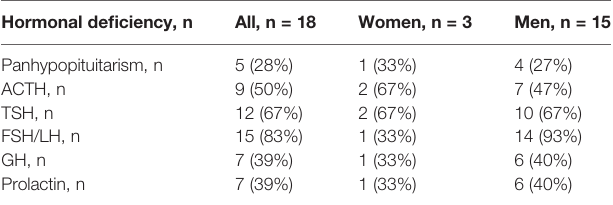
TABLE 2 | Speci fi cation of the hormonal de fi ciencies encountered in 33 patients with pituitary apoplexy. Hormonal de fi ciency, n All, n =